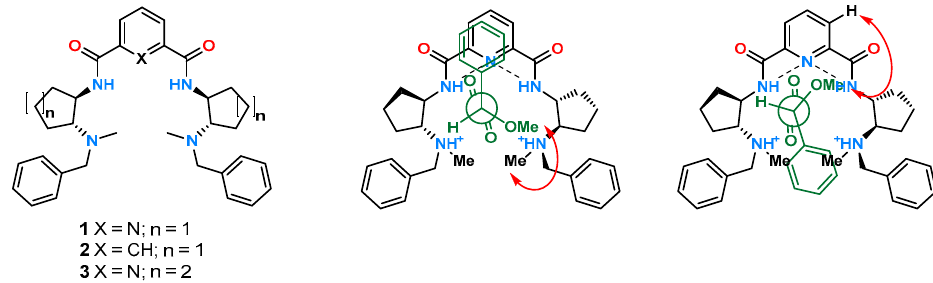
Figure 2. Chiral receptors 1–3 incorporating chiral 1,2-disubstituted cyclic amines.